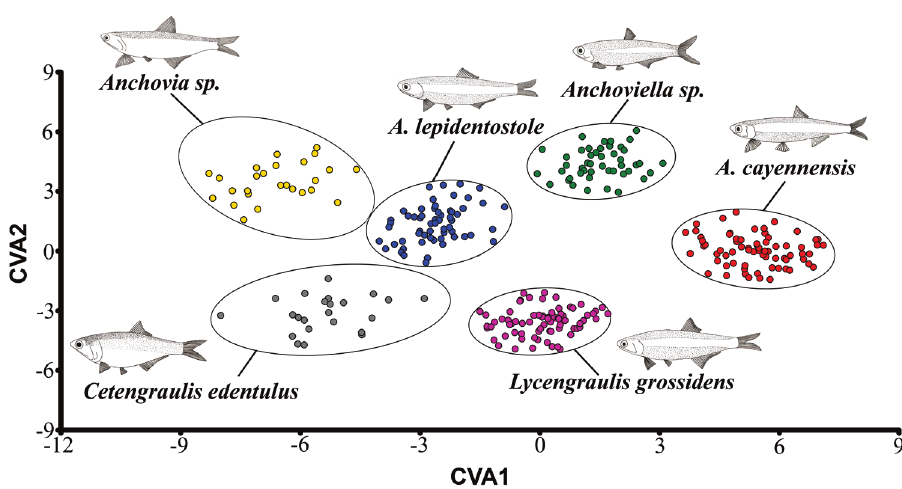
FIGURE 5 | Canonical Variables Analysis discriminating for six pilombetas species.